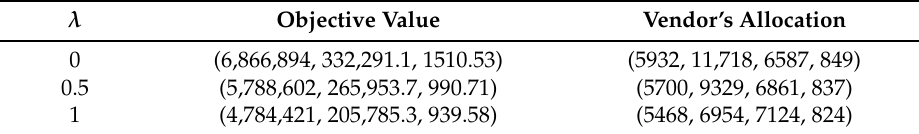
Table 13. Compromise objective value and allocation for case 3 without fixed